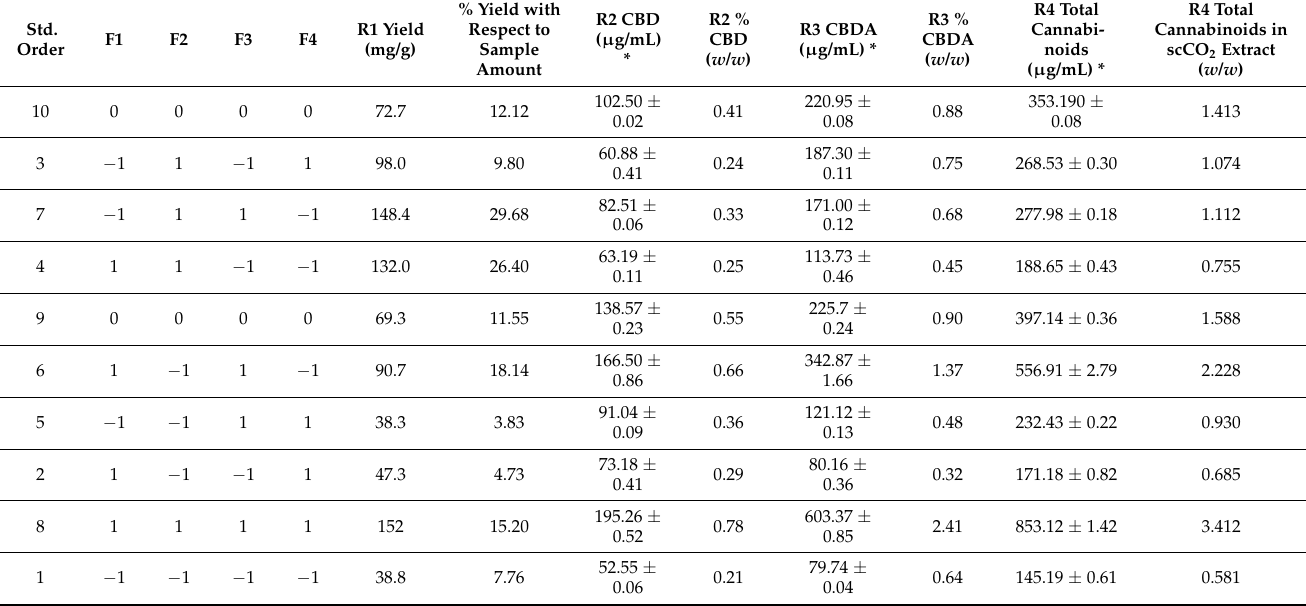
Table 3. HPLC quantification for supercritical carbon dioxide extract yield, cannabidiol (CBD), cannabidiolic acid (CBDA), and total cannabinoids.